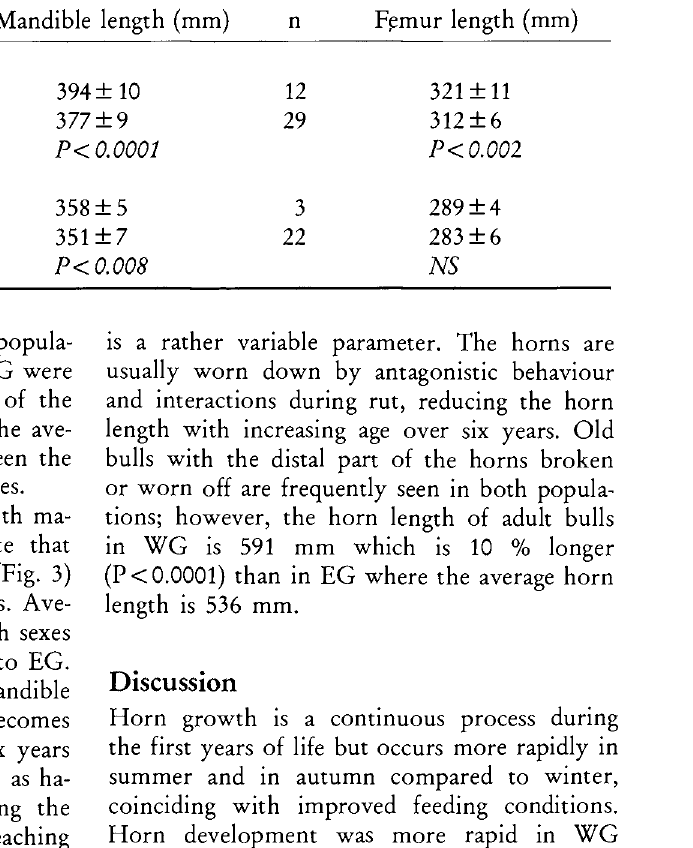
Table 3. Width of horn base and length of horn (one side) in adult male (4+ years) Angujaartorfiup Nu naa, West Greenland (WG) and Jameson Land, East Greenland (EG). Mean ±